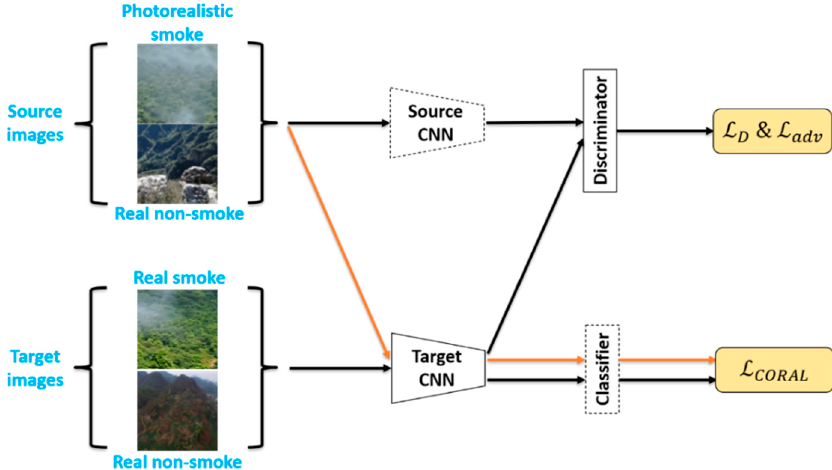
Figure 7. The adversarial adaptation phase of feature-level domain adaptation.